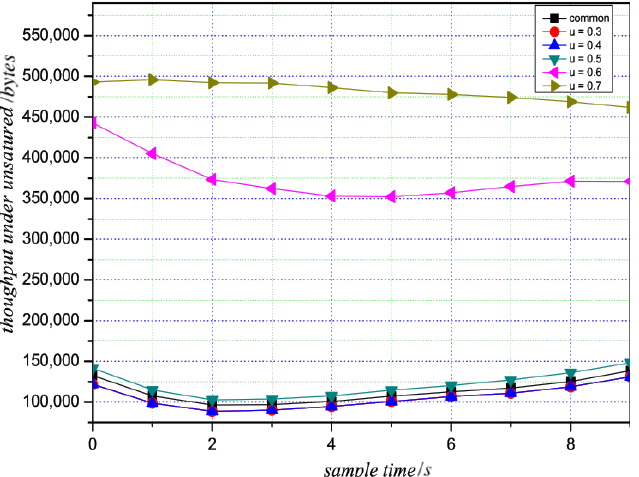
Figure 13. Throughput under different values of µ under